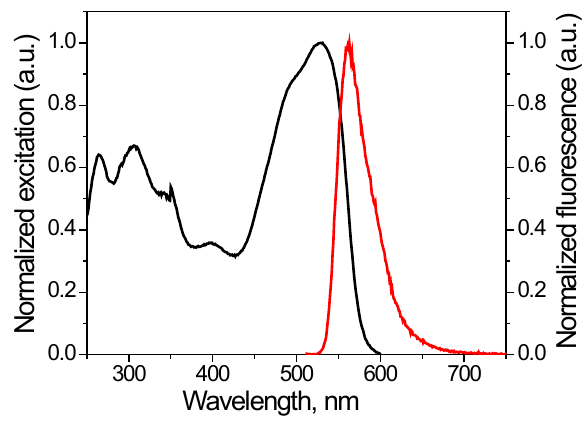
Figure 3: Normalized excitation (black) and fluorescence (red) spectra of compound E loaded on the cotton